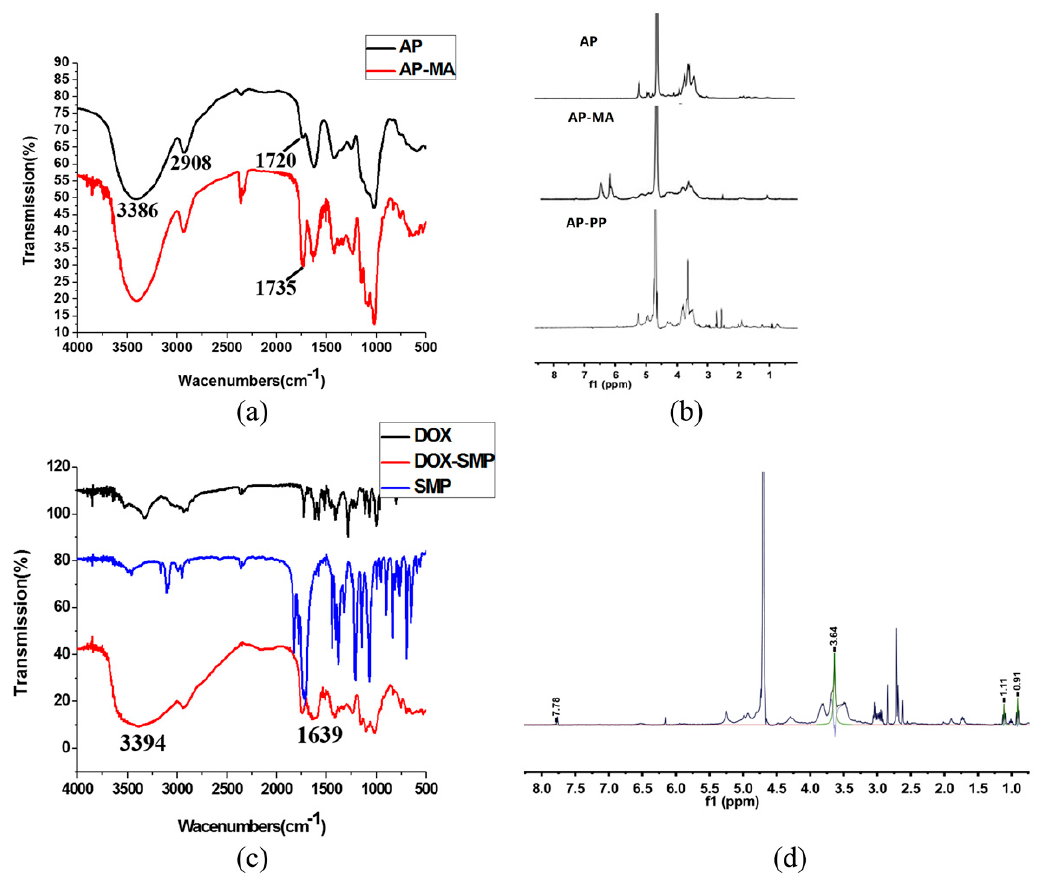
Figure 3. ( a ) FT-IR spectrum of AP and AP-maleic anhydride (MA). ( b ) 1 H-NMR spectrum of AP, AP-MA, and AP-PP. ( c ) FT-IR spectrum of DOX, 3-(Maleimido) propionic acid N -hydroxysuccinimide ester (SMP), and DOX-SMP. ( d ) 1 H-NMR spectrum of AP-PP-DOX.